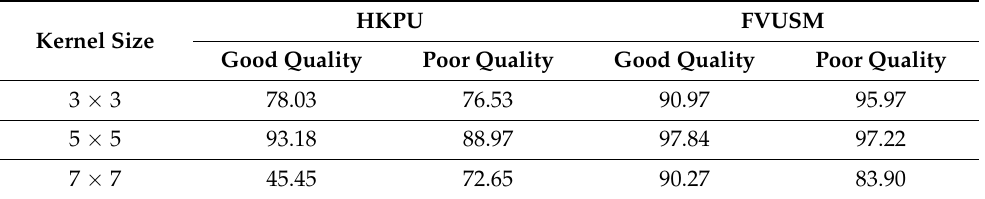
Table 7. Impact of Varying Kernel Size on the Recognition Performance of the FVR-Net. HKPU Kernel Size Good Quality